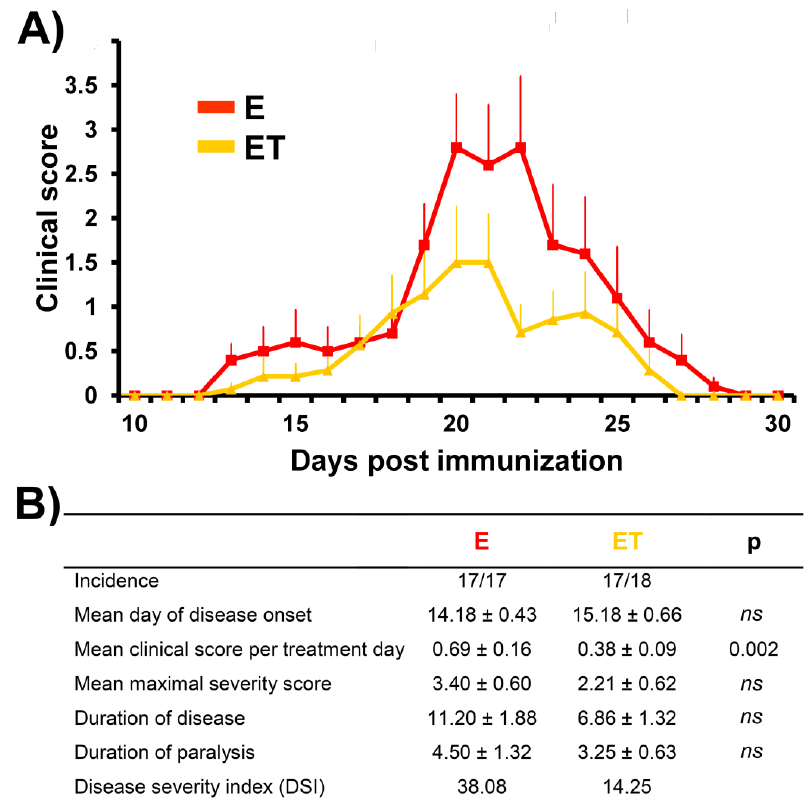
Figure 2. Clinical scores of untreated EAE rats (E) vs. VBC-treated EAE rats (ET) during the disease course. ( A ) The mean clinical scores of rats were monitored daily and the animals were sacrificed as described in Materials and Methods. Animals in E group were immunized and 150 μ L saline was applied daily as i.p. injection from the onset of immunization (0 dpi) until the end of experiment (30 dpi). Animals in ET group were immunized and treated with cocktail of B vitamins (B1, B2, B3, B5, B6, B12) at a dosage 1.85 mL/kg body weight/every day, i.p. , from the onset of immunization (0 dpi) to 30 following days (end of experiment). ( B ) The effect of VBC treatment on parameters of the disease. Data are expressed as mean ± standard error (SE), ns —nonsignificant.